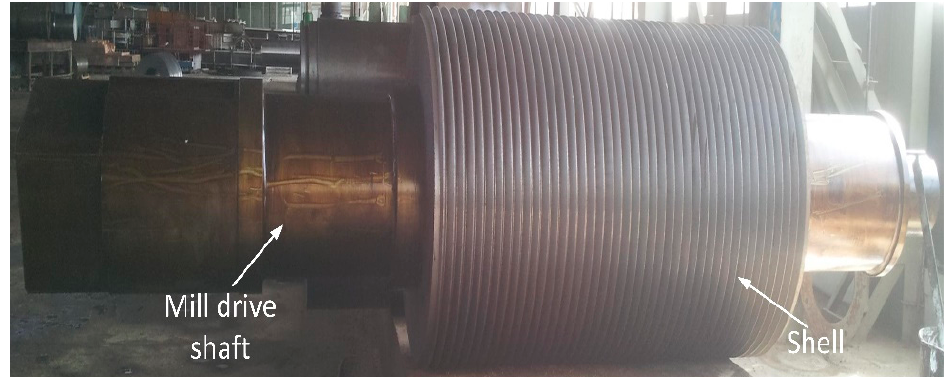
Figure 1. Sugar mill roller shaft with final groove ready for shipment.